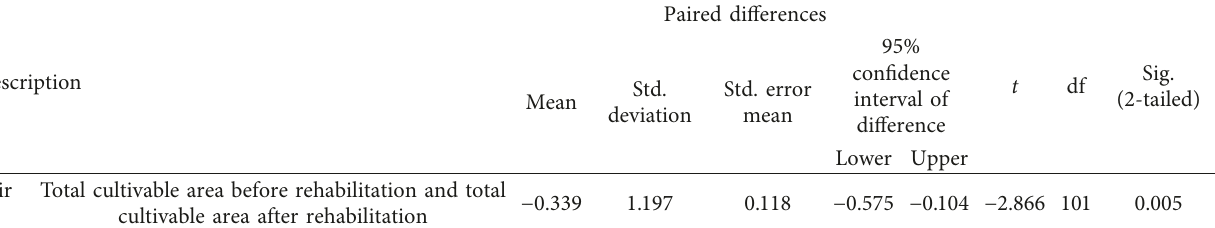
Figure 3: Season-wise total area cultivated before and after rehabilitation. Table 5: Paired samples t -test for total area cultivated before and after